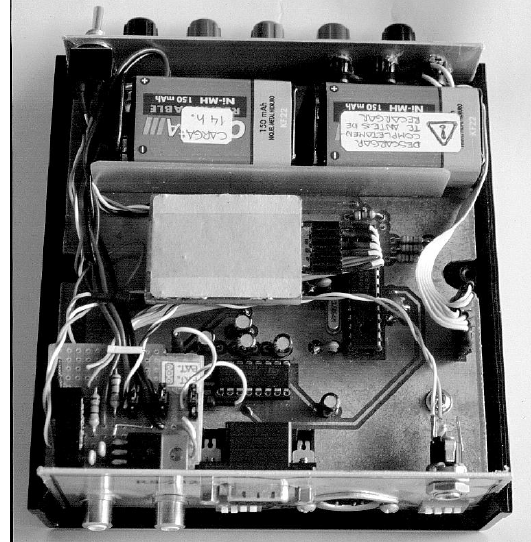
Figure 2. Assembled unit for signal-conditioning and communication with the